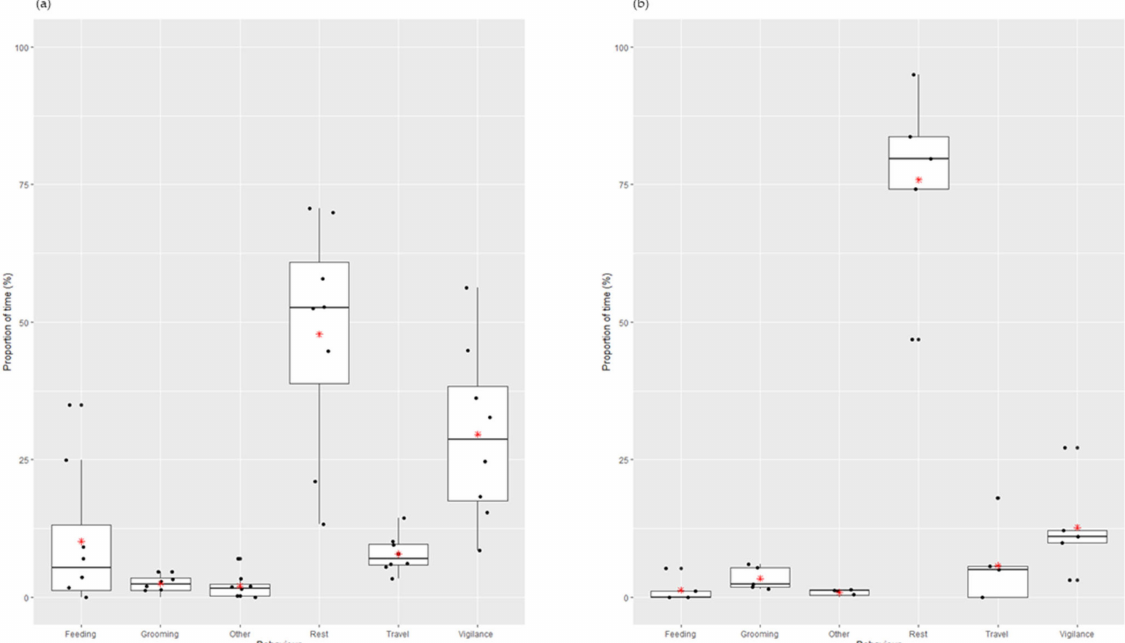
Figure 1. Proportion of time (%) the ( a ) male study subject and ( b ) female study subject engaged in each behavioural category throughout the data collection period. Time budget displayed using boxplots outlining the first quartile, median, third quartile and range of the data. Jitter plots used to visualize each collected data point represented by black circles. Red star denotes the mean value of time spent engaging in each behavioural